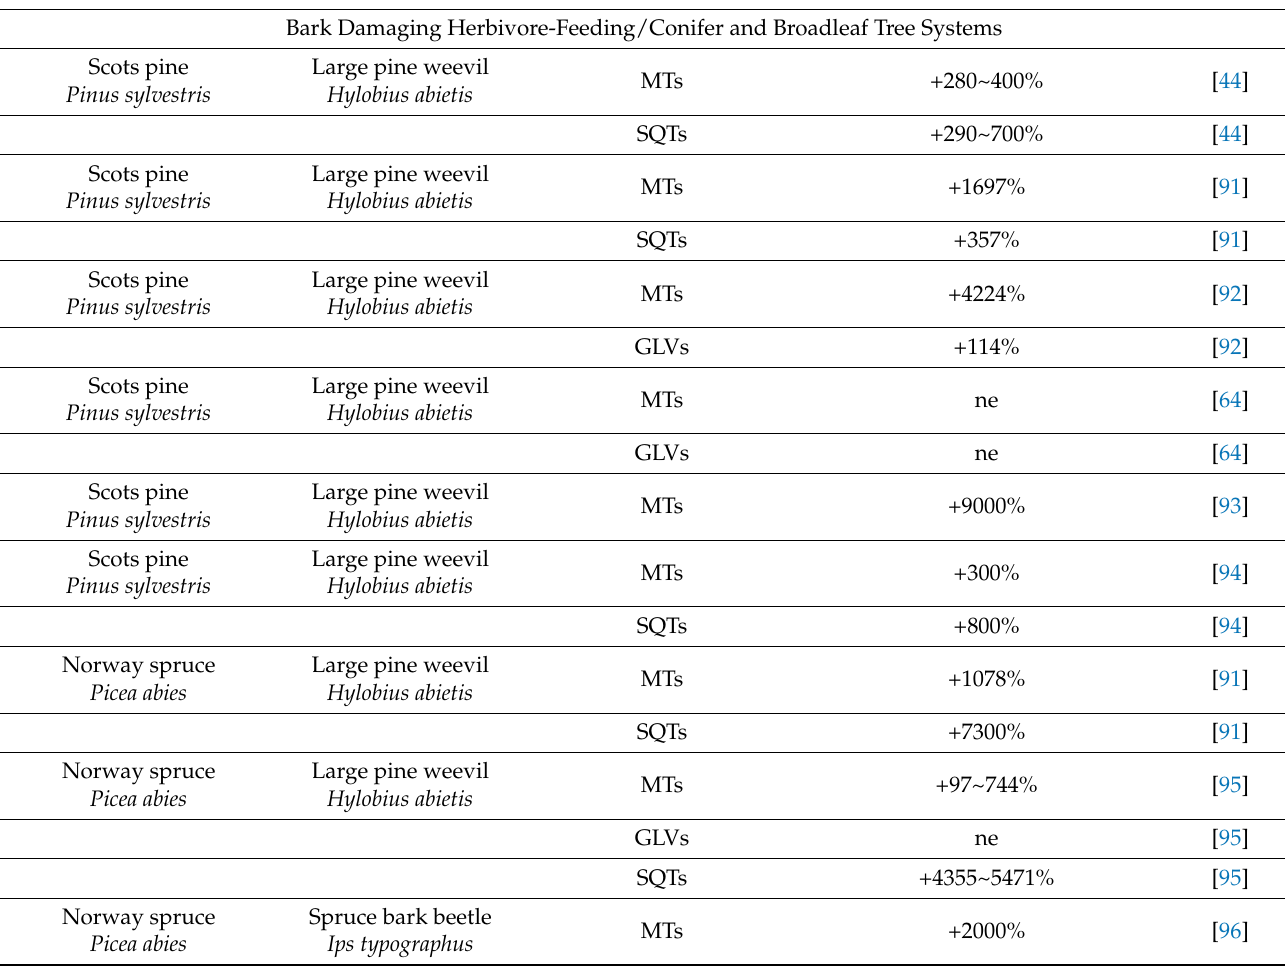
Table 3. Examples of insect herbivory impacts on emissions of non-oxygenated monoterpenes (MT-no), oxygenated monoterpenes (MT-ox), monoterpenes (MT-no + MT-ox, MTs), sesquiterpenes (SQT), green leaf volatiles (GLV) and Methyl salicylate (MeSA). ‘+’ shows the size of increasing warming effects; ‘ne’ means no warming effects. Change in Temp. Standardized Tree Species Herbivory Responding Compounds Emission